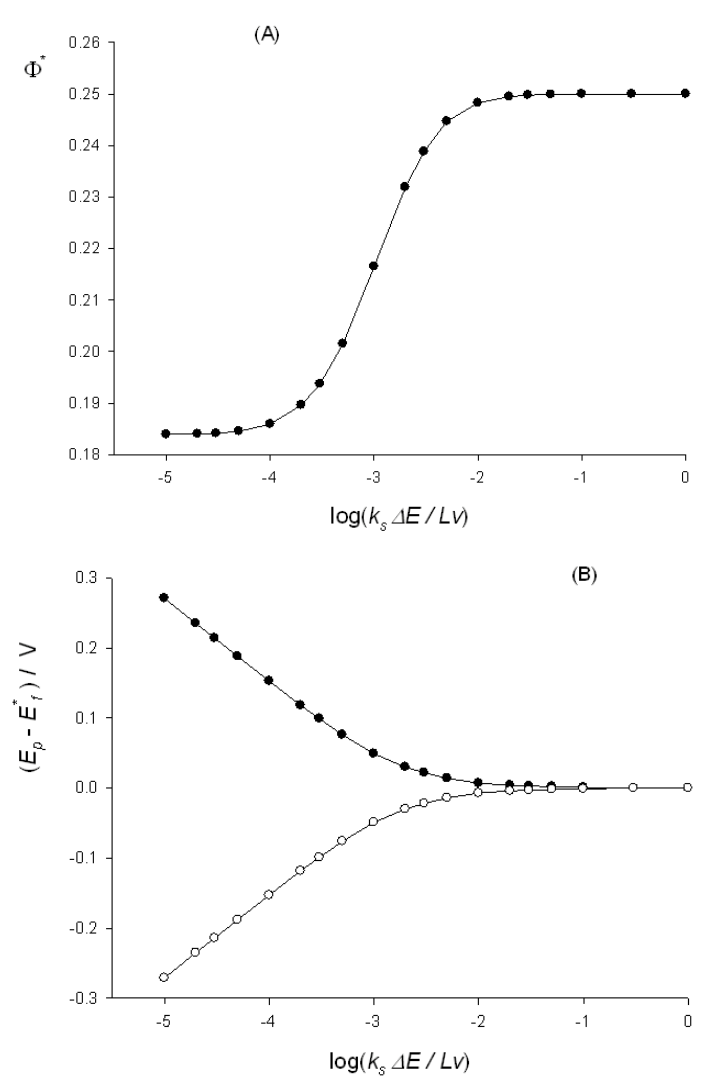
Fig. 5 Dependence of dimensionless peak currents (A) and peak potentials (B) of cyclic vol- tammograms of quasireversible reaction (1) on the logarithm of dimensionless standard rate constant, for α =